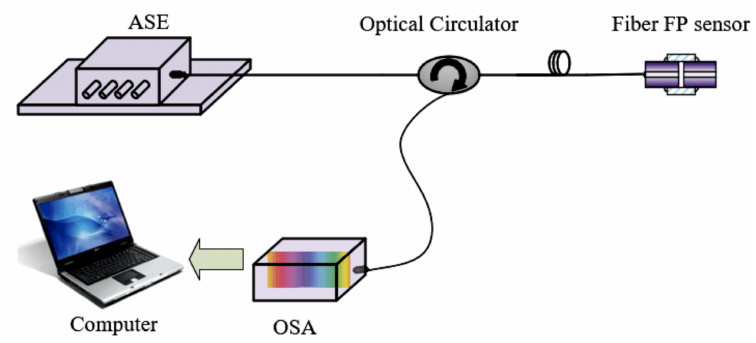
Figure 3. A white light fiber FP sensor spectral interrogation system. ASE is amplified spontaneous emission; OSA is optical spectral